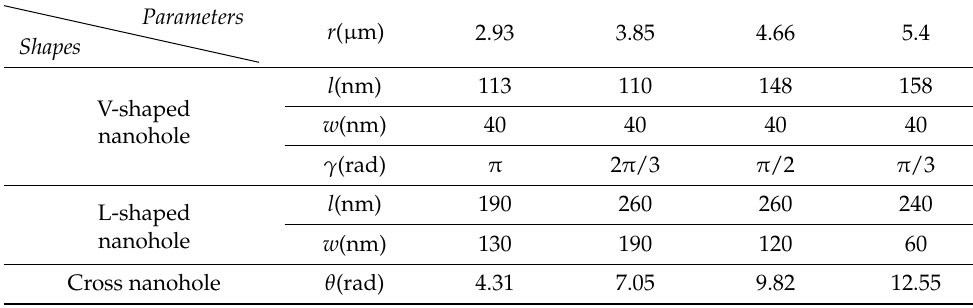
Table 1. Structure parameters of three metalenses with f = 4.5 µ